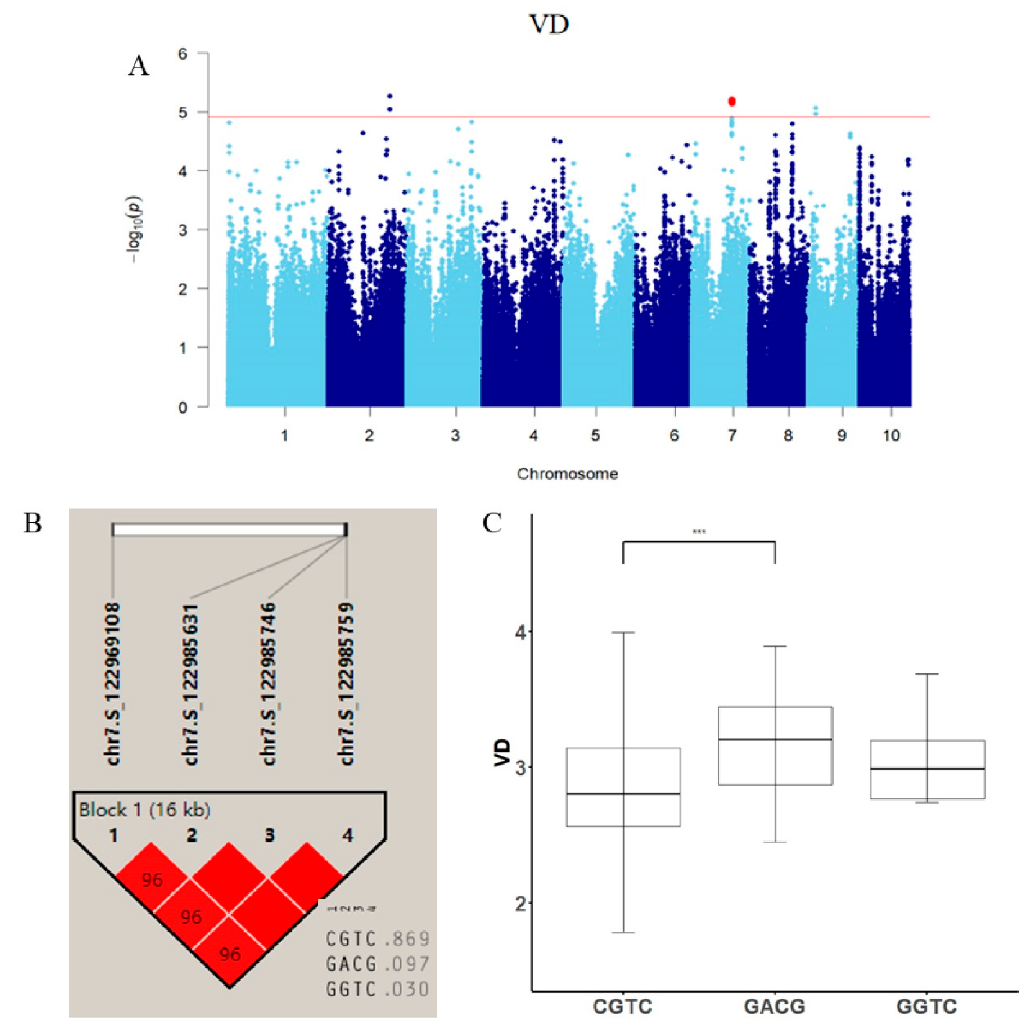
Figure 8. Analysis of haplotype ( A , B ) and phenotypic difference ( C ) of SNPs related to the vein density of maize ear leaf. *** p ≤